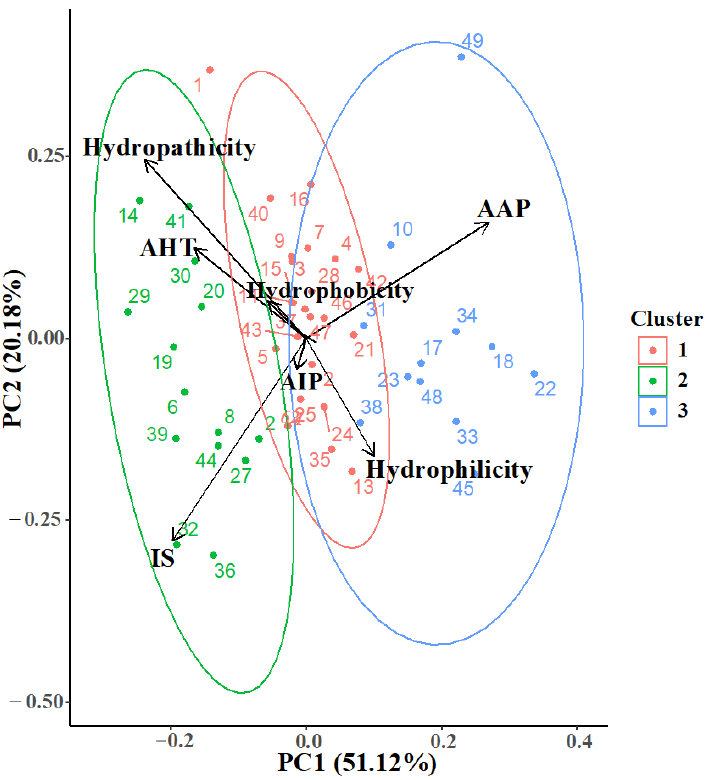
Figure 1. Principal Component Analysis of calculated physicochemical and bioactivity properties. AAP, antiangiogenic; AHT, antihypertensive; AIP, anti-inflammatory; IS, Intestinal Stability. Each dot corresponds to a peptide in the library (Table 1).